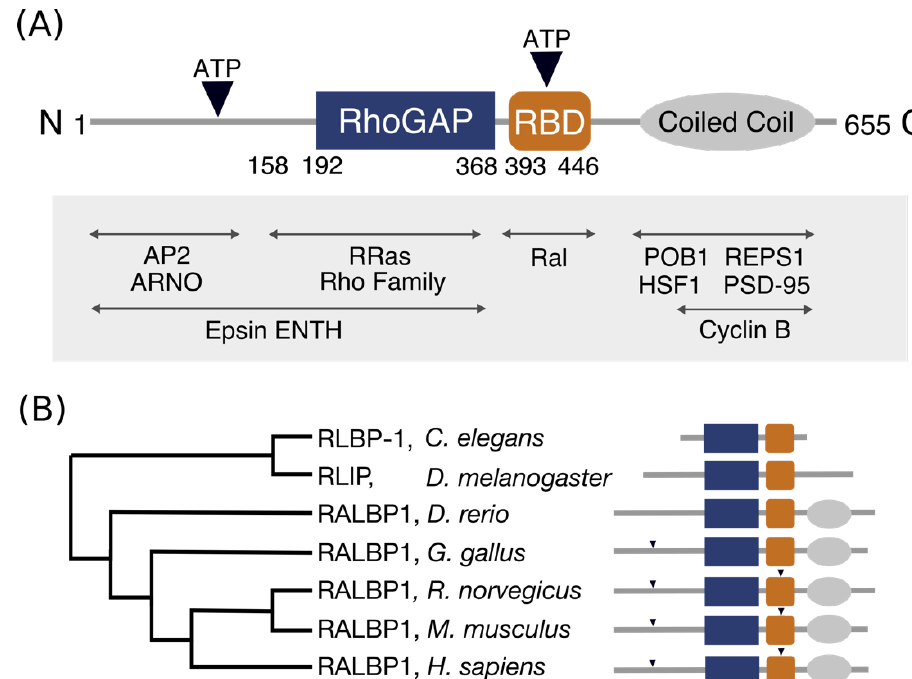
Figure 1. Architecture and conservation of the domains in RLIP76. ( A ) Domain architecture of RLIP76. The central RhoGAP and Ral binding domains are flanked by structurally uninvestigated N- and C-termini. The C-terminus is predicted to form a coiled coil, while the N- terminus is predicted to be disordered. The positions of two ATP binding sites are indicated by inverted triangles. Known interactions are labelled, with their approximate binding regions indicated by arrows. ( B ) Phylogenetic tree of RLIP76 in a subset of organisms. The schematic (styled as in Figure 1A) shows the conserved features for each organism. Only the RhoGAP and RBD are conserved in Caenorhabditis elegans . The predicted coiled-coil is present in Danio rerio through to Homo sapiens , while the two ATP binding motifs are present in Rattus norvegicus , Mus musculus and Homo sapiens